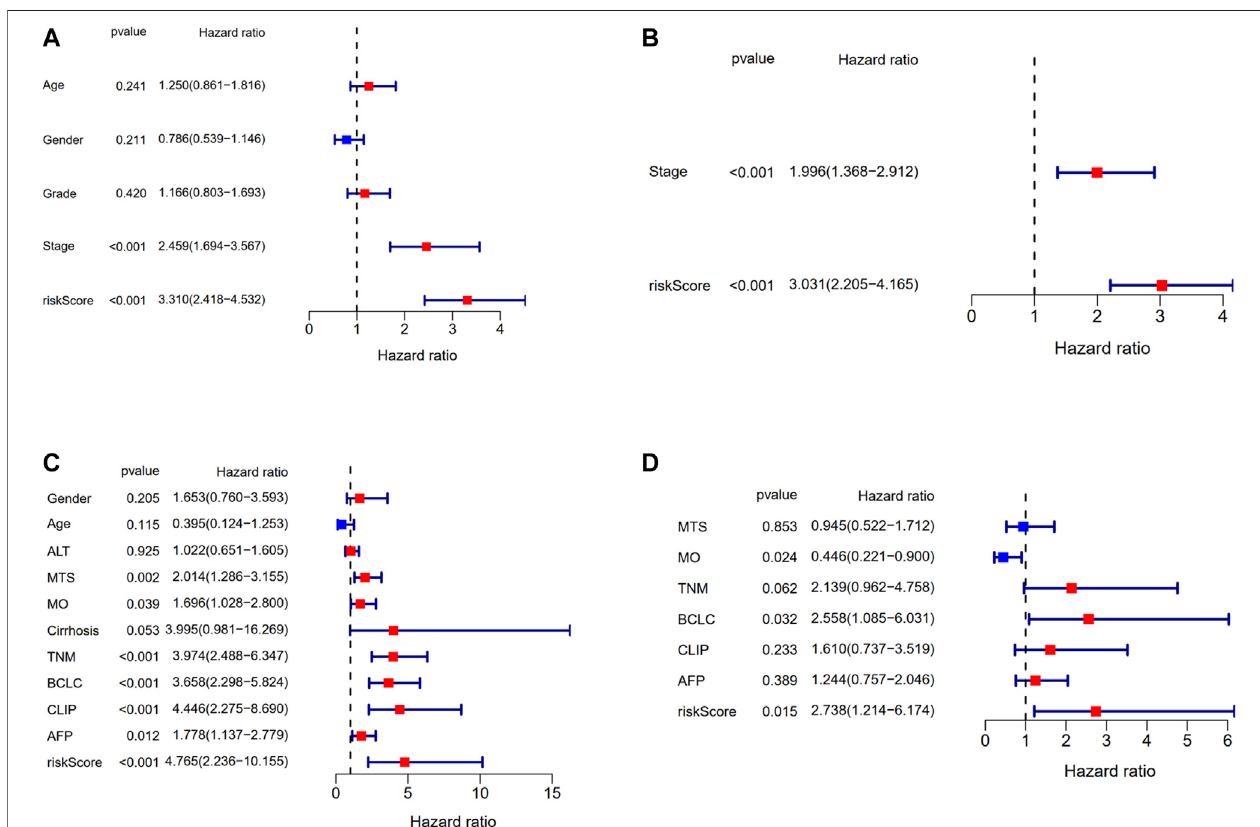
FIGURE8| ResultsoftheunivariateandmultivariateCoxregressionanalysesregardingOSintheTCGAderivationcohortandtheGSE14520validationcohort. (A) Univariate Coxregression analyses in theTCGA derivation cohort. (B) Multivariate Coxregression analyses inthe TCGA derivation cohort. (C) Univariate Coxregression analyses in the GSE14520 validation cohort. (D) Multivariate Cox regression analyses in the GSE14520 validation